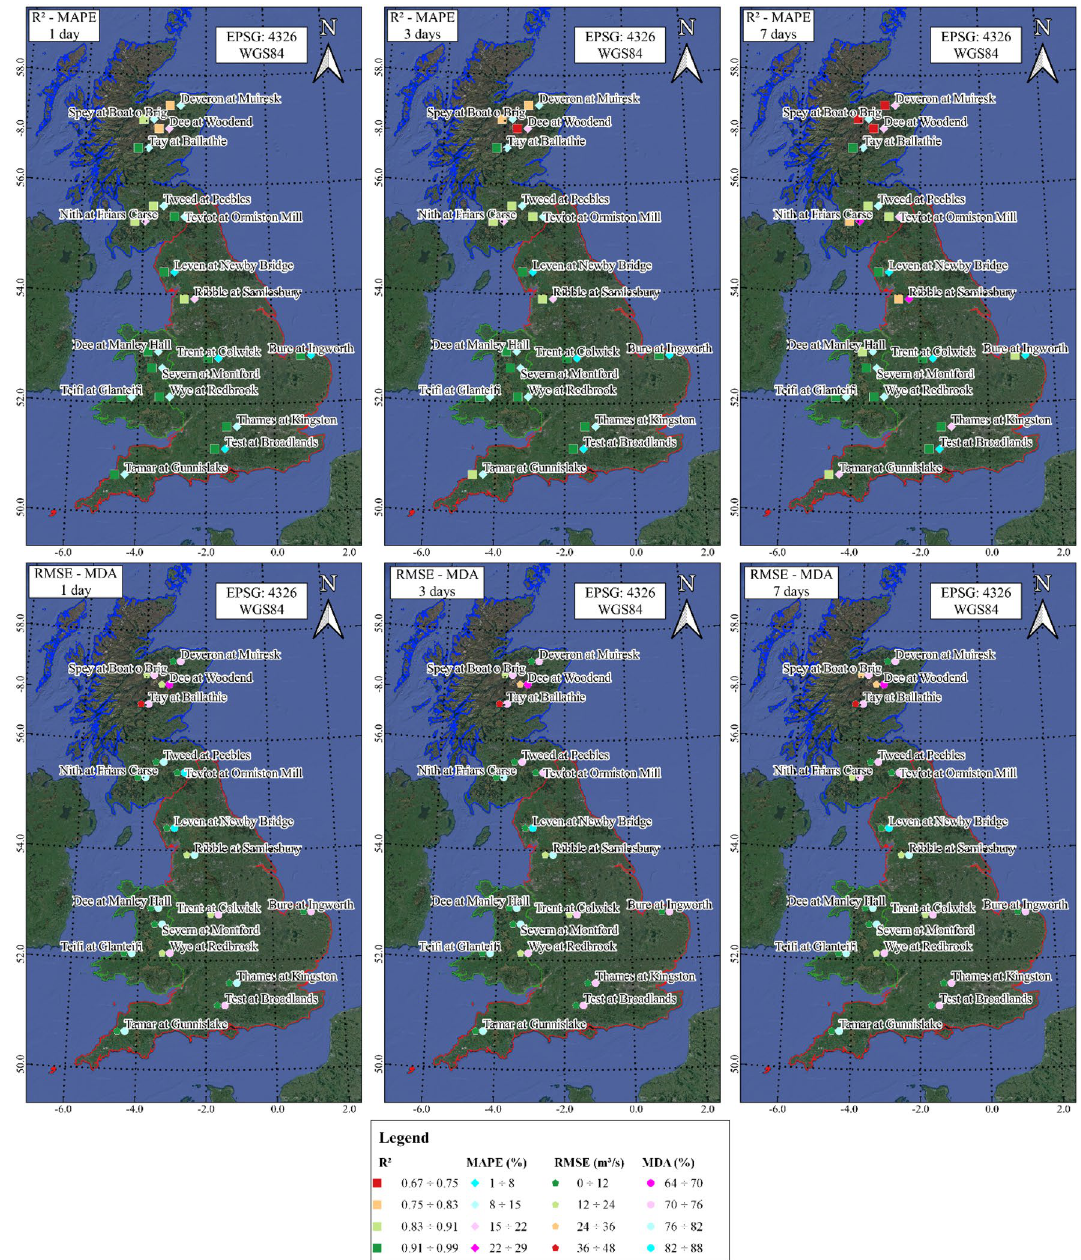
Figure 14. NARX-MLP-RF, testing stage: R 2 —MAPE (on the top) and RMSE—MDA (on the bottom). Maps created using the Free and Open Source QGIS 25